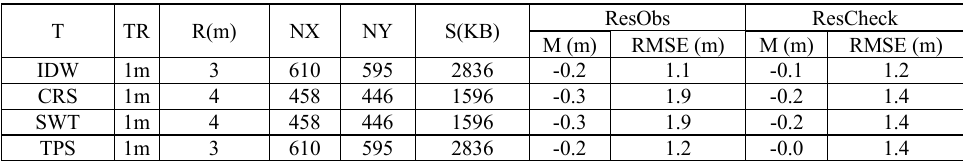
Table 5. Characteristics of the grids interpolated from TR1 with accuracy similar to DTM MR . T: technique used to interpolate; R: spatial resolution; NX and NY: number of nodes in X and Y; S: storage size; ResObs, ResCheck: statistics of the residual on the used observations and the check points; M: mean; RMSE: root mean square